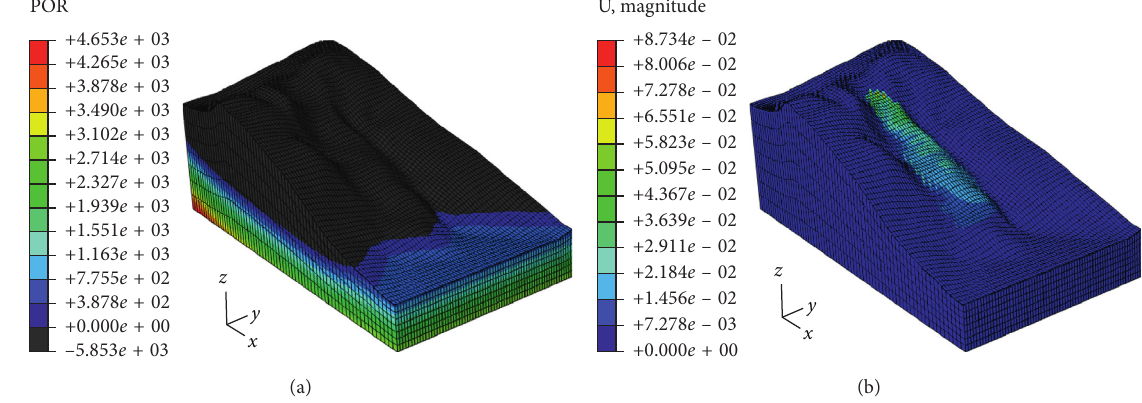
Figure 11: Deformation distribution diagram under condition 3. (a) Pore pressure distribution. (b) Displacement